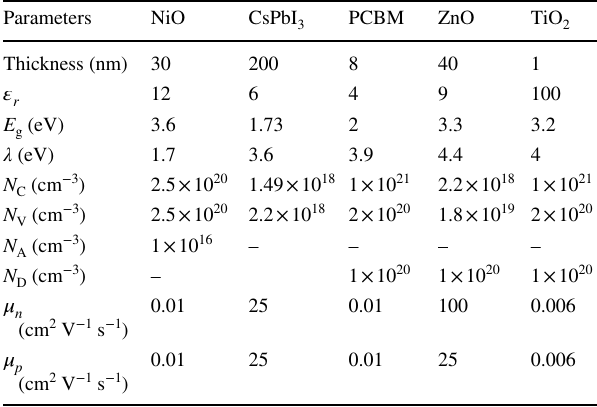
N v is the effective valence